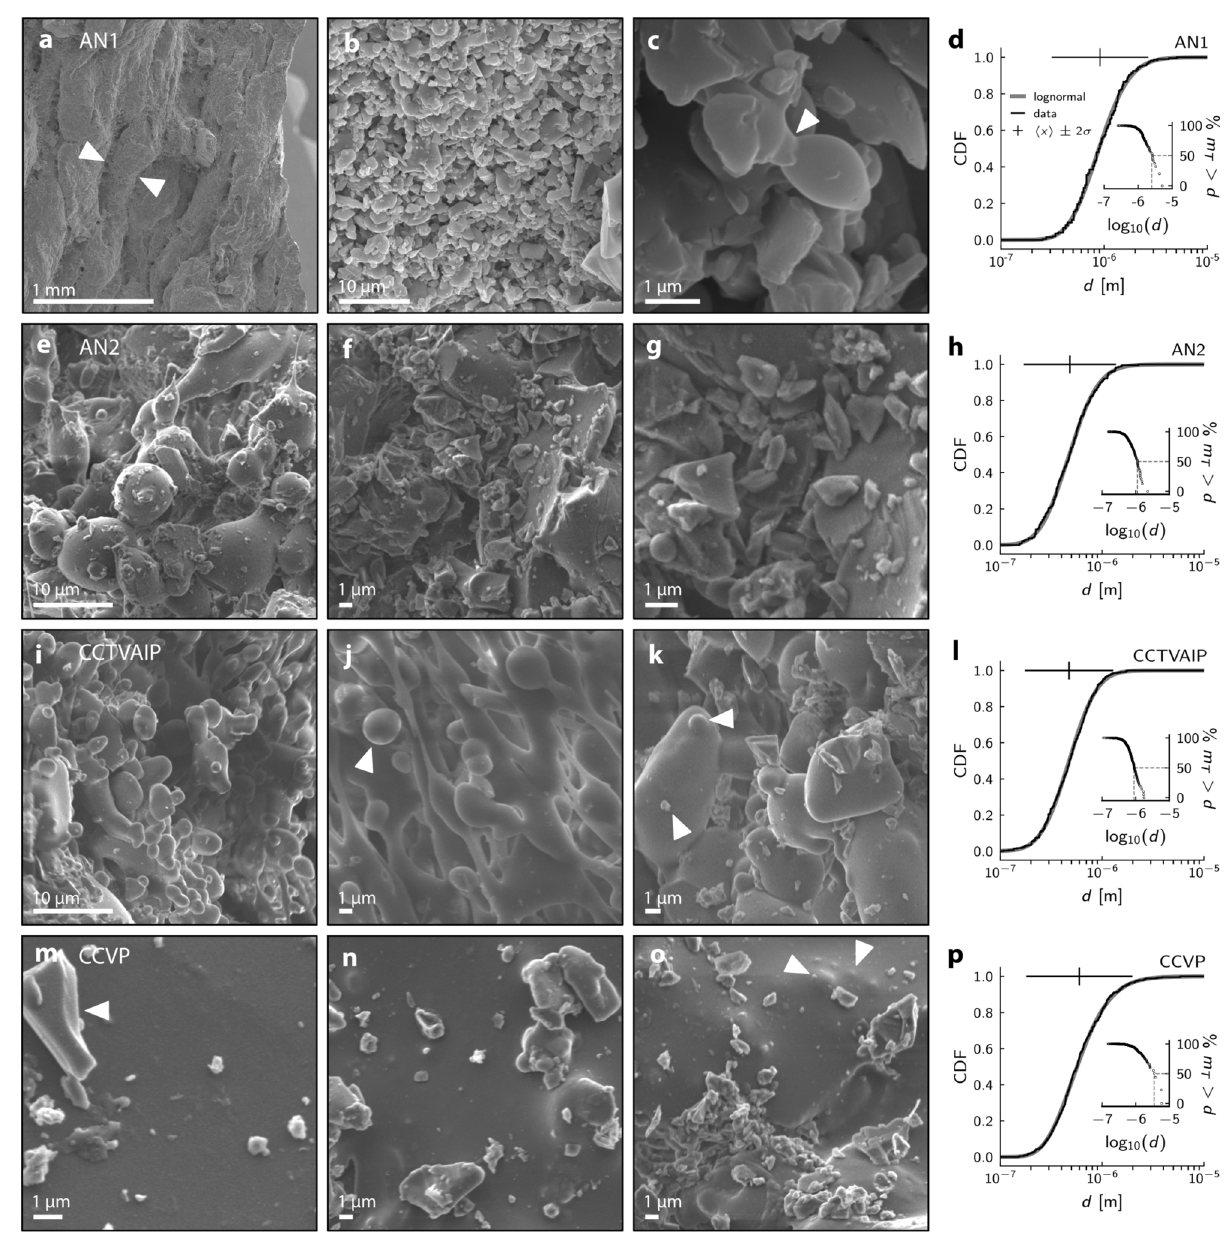
Fig. 2 | Particle sizes in sintered veneers on in-vent lava fractures that fed ash- ventingduringhybridexplosive-effusiveeruptions.a – c SEMimagesoffracture- wallsurfacetexturesinsampleAN1.Ropytexturesarehighlightedin a ;evidenceof neck formation highlighted in c . d Cumulative distribution (cdf) of particle dia- meters d , compared with a lognormal function 1+erf ln x (cid:1) x h i = σ de fi ned by the mean x h i and standard deviation σ of the logarithm of the data x . Density distribution of particles shown as x h i (vertical tick) and 2 σ range (hor- izontal line). Inset shows the mass proportion (assuming spherical particles and